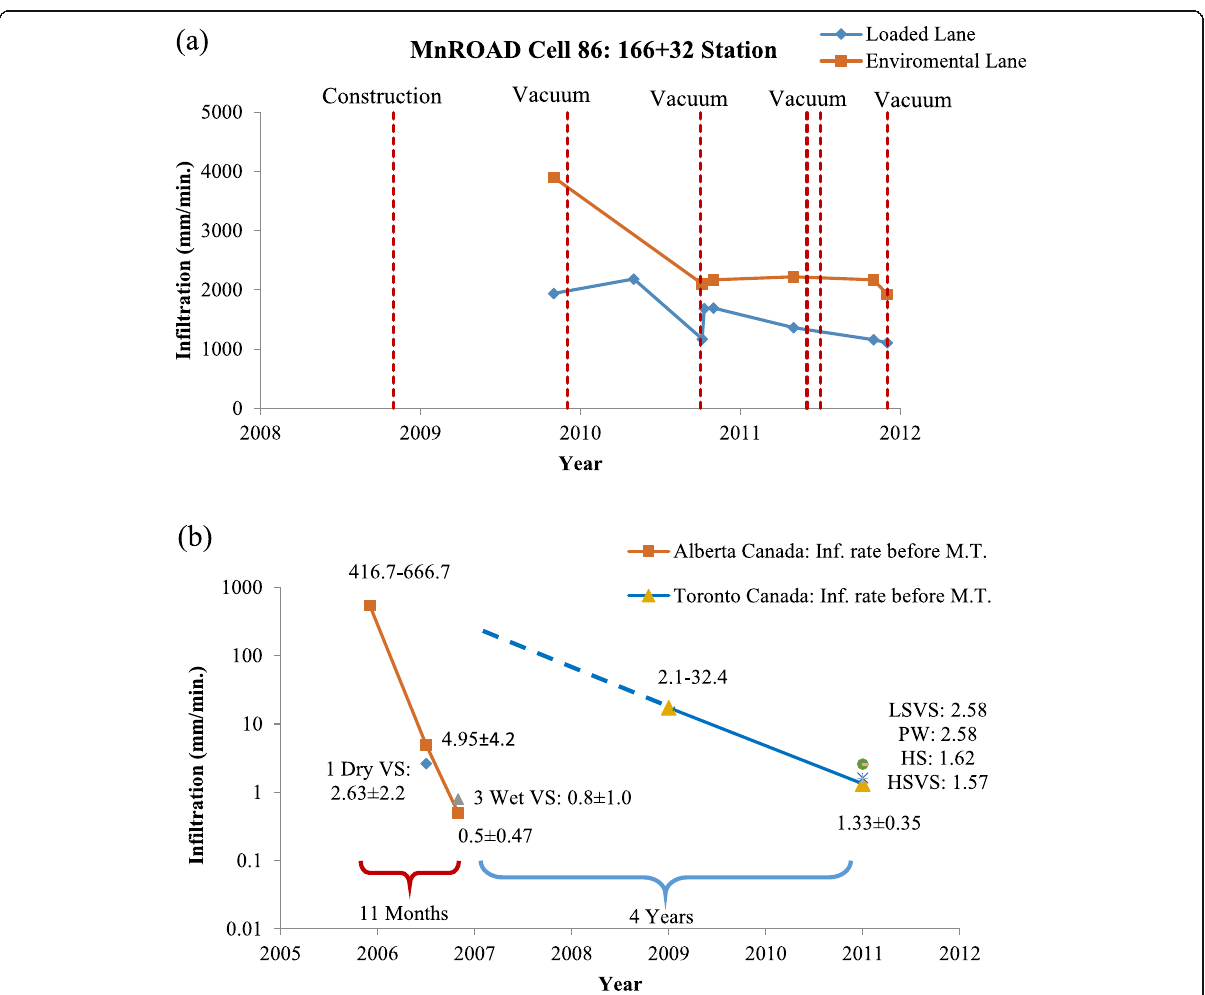
Fig. 2 Short-term infiltration rate and restorative maintenance for porous asphalt pavements at ( a ) MnROAD test sections, MN, USA [32] and ( b ) Alberta 1 , Canada [10] and Toronto 2 , Canada [15, 16]. (Acronym: Inf. = infiltration; M.T. = maintenance; VS = vacuum sweeping; HS = hand sweeping; PW = pressure washing; LSVS: low suction vacuum sweeping (airflow of 5.95 m 3 /min.); HSVS = high suction vacuum sweeping (airflow of 7.93 m 3 /min.)). 1 The infiltration rate of this project is calculated based on the average testing results along the center of the pavement. 2 The initial infiltration rate of this project is not available and the dashed line is